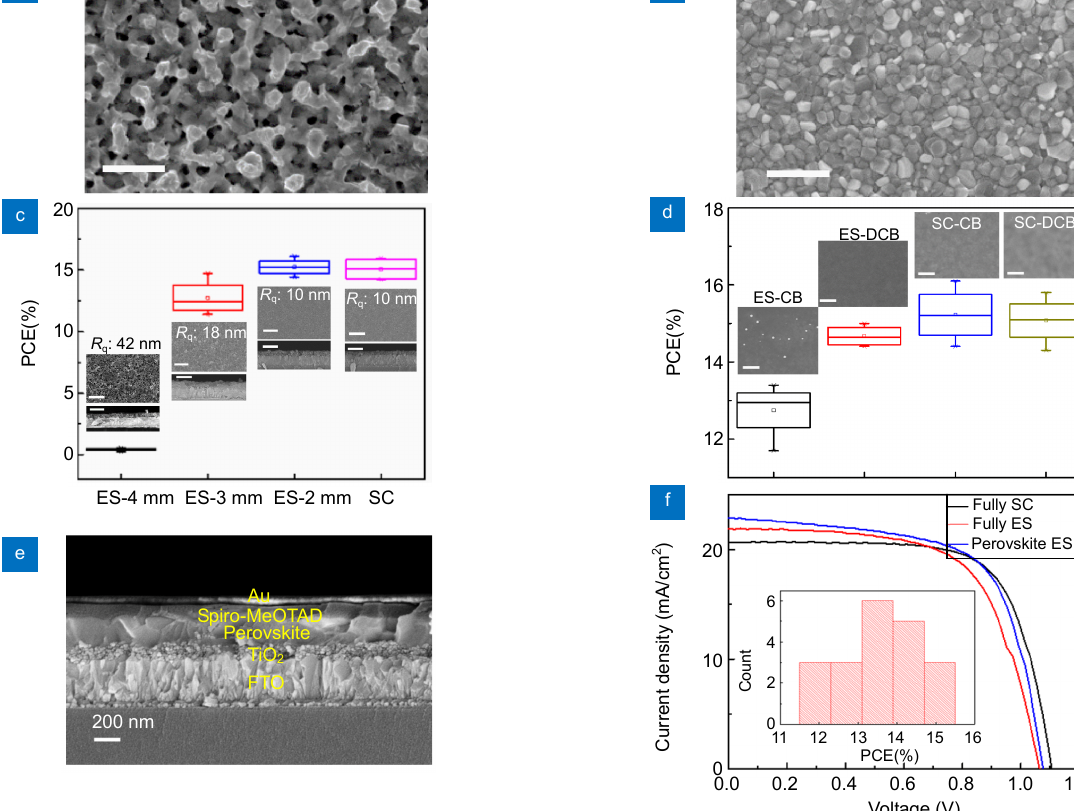
Fig. 10 | Top-view SEM images of electrospray printed film when (a) t f > t e and (b) when t f < t e ; the scale bar is 1 micron. (c) PCE of electrospray